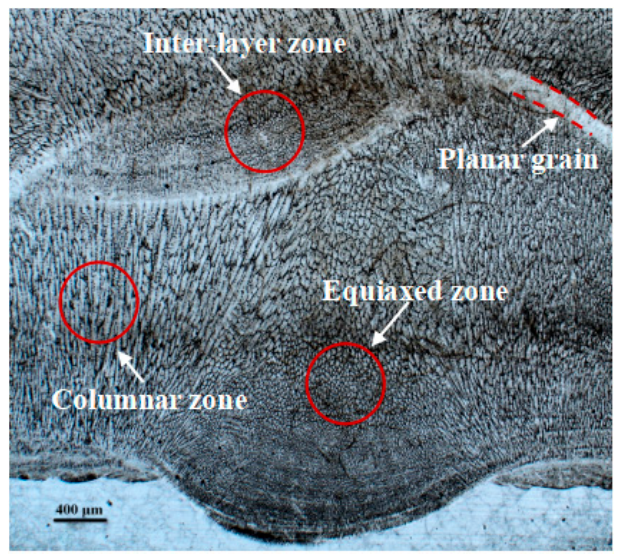
Figure 6. Three typical regions of microstructure in the process of WAAM.